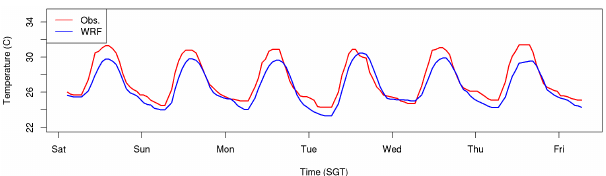
Figure 4. Time series plot of the hourly observed and model simu- lated temperatures at the Changi meteorological station during 21– 27 February 2014.